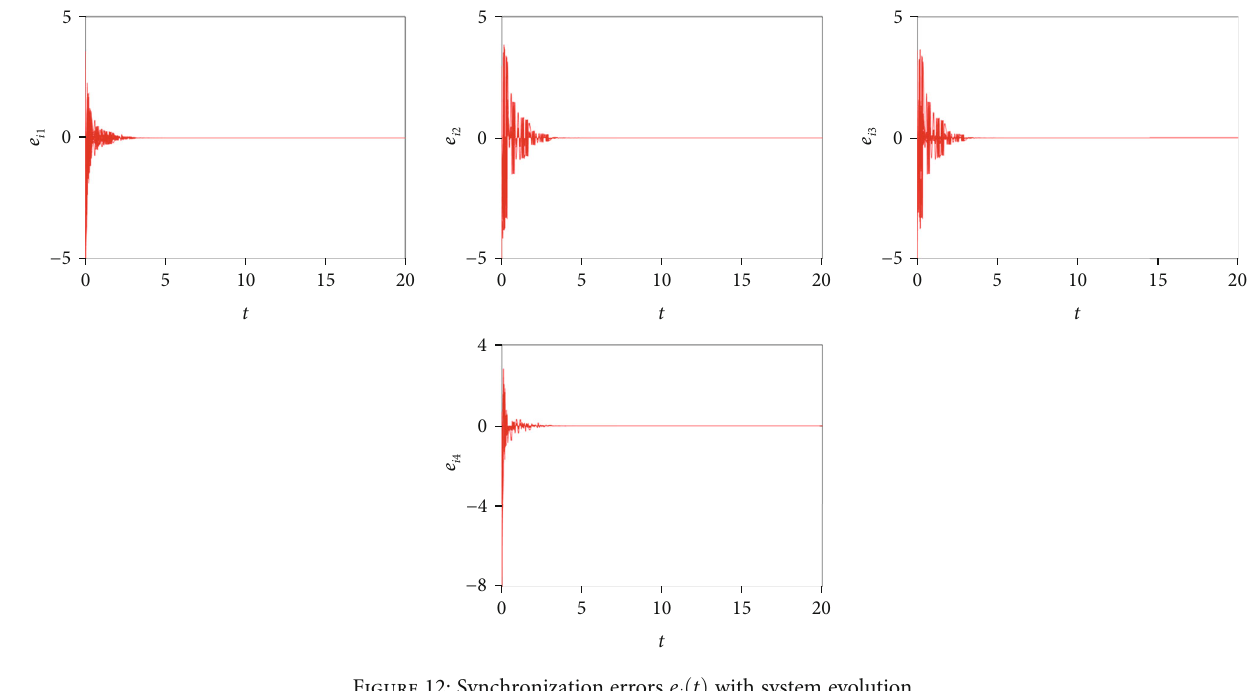
ð t Þ with system evolution. i